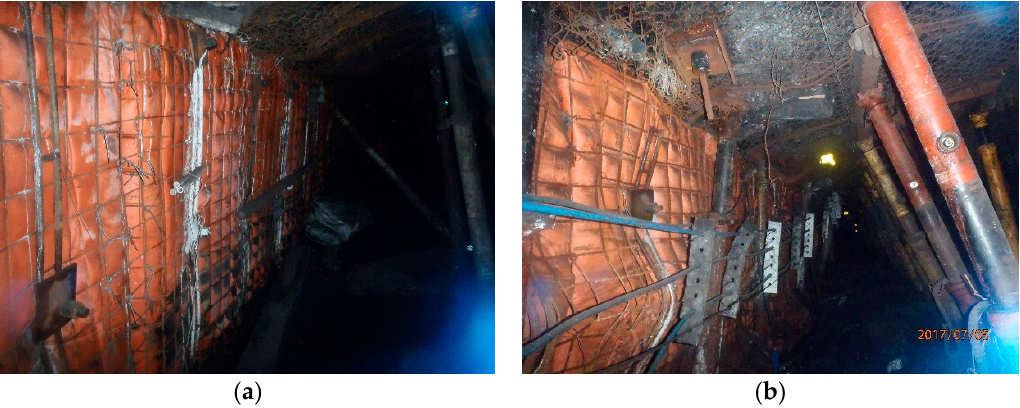
Figure 15. Comparison of the deformation of the gob-side retaining entry with and without shallow hole blasting: ( a ) with shallow-hole blasting; ( b ) without shallow-hole blasting.